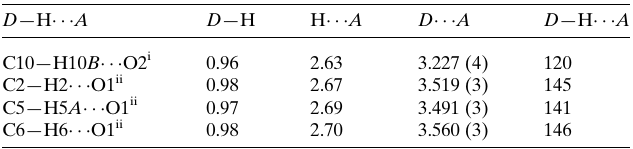
Table 1 Hydrogen-bond geometry (A˚ , (cid:2)